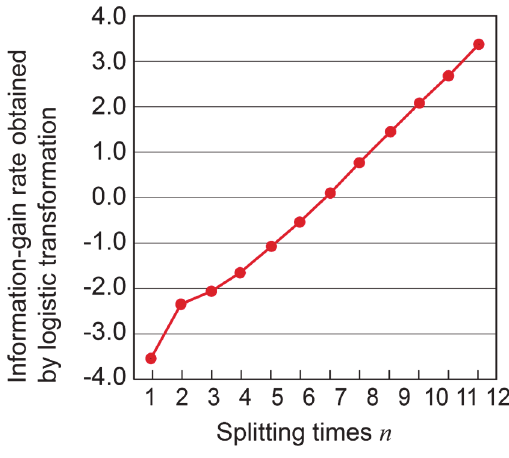
Figure 7 . Logistic